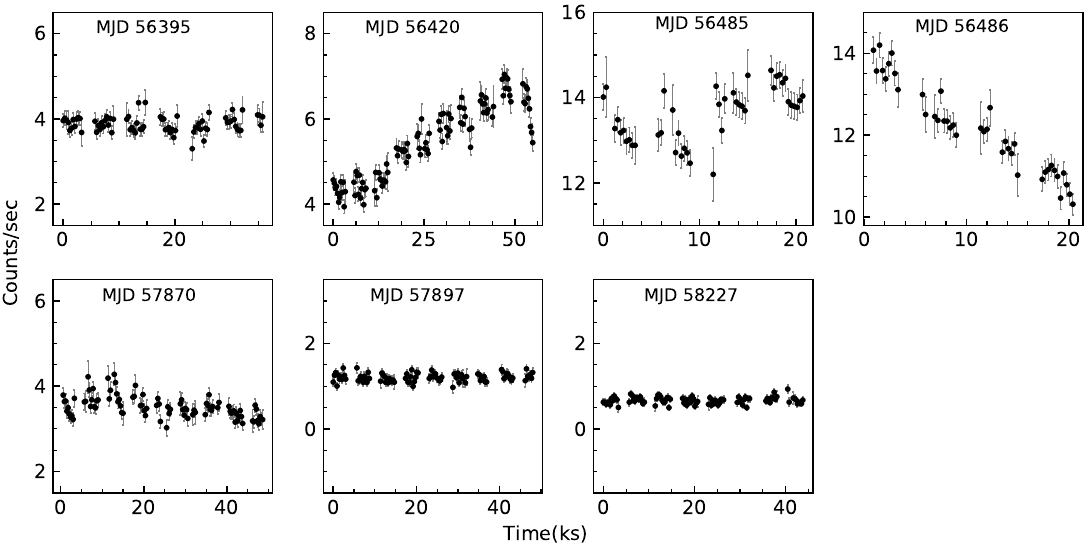
Figure 1. NuSTAR light curves of the TeV blazar Mrk 501. The MJD of observation is given in each plot.